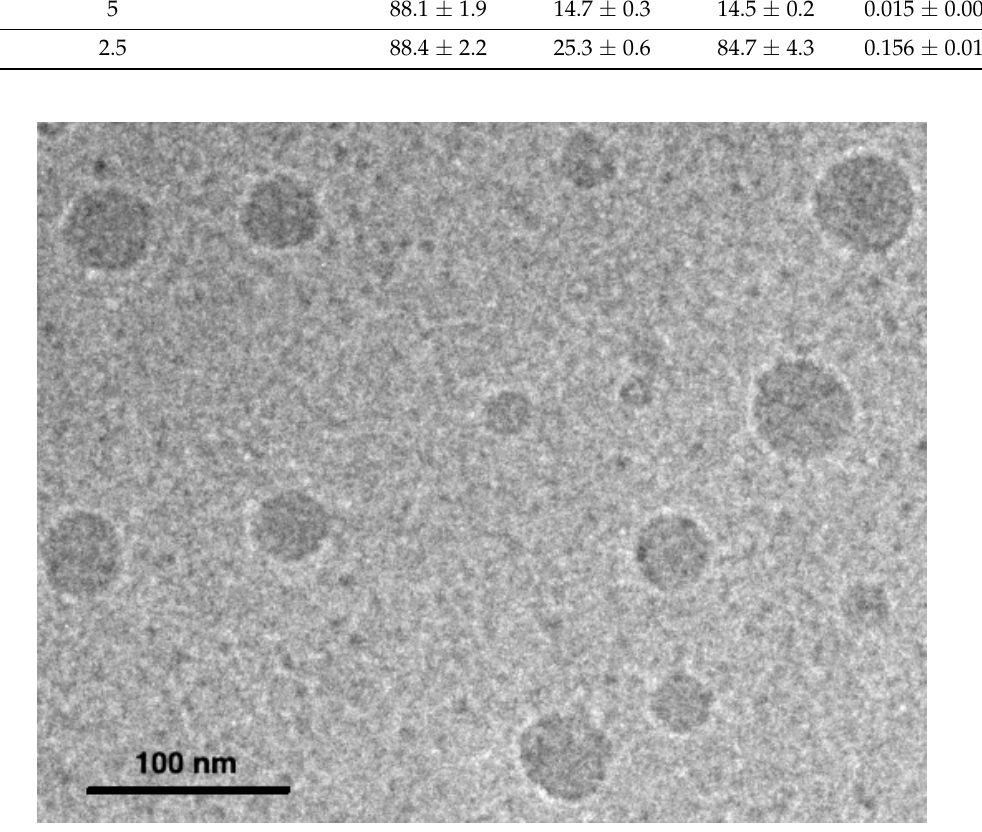
Figure 8. Cryo-TEM micrograph of micelles in the presence of rapamycin (formulation F3—2.5).